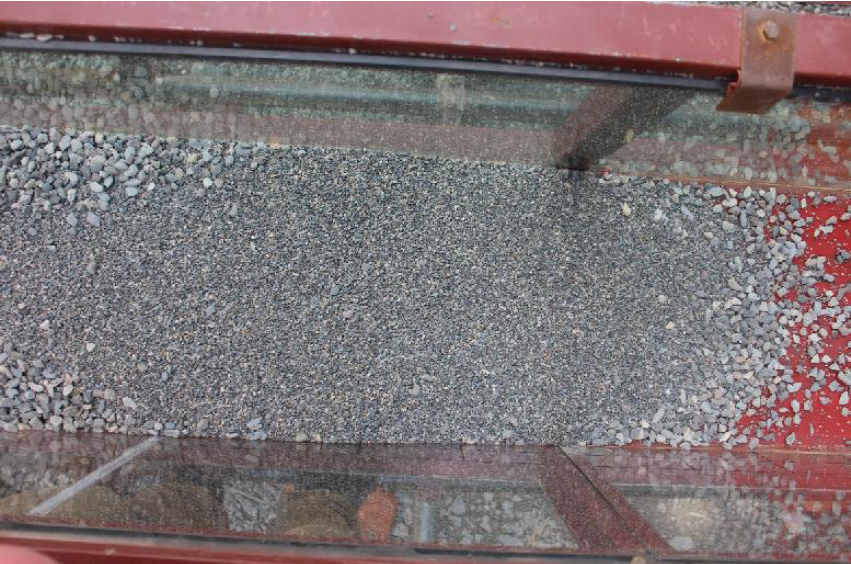
Figure 19. Front of the